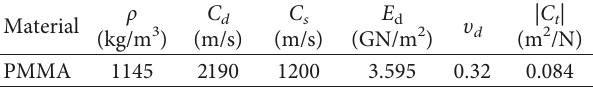
Table 1: Dynamic optical constants of the model material. Material